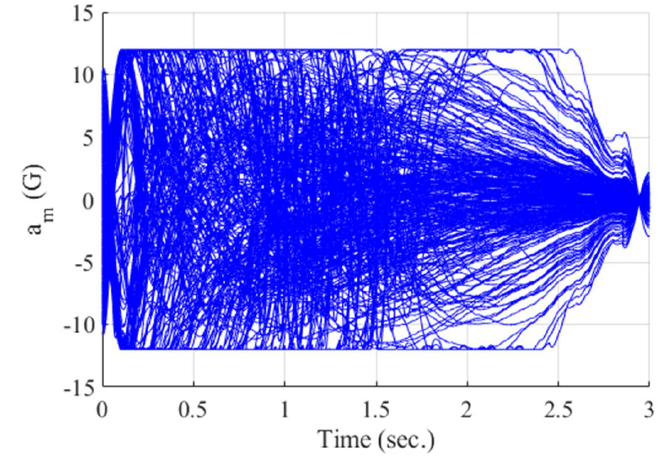
Figure 14. Acceleration of the missile (Monte Carlo